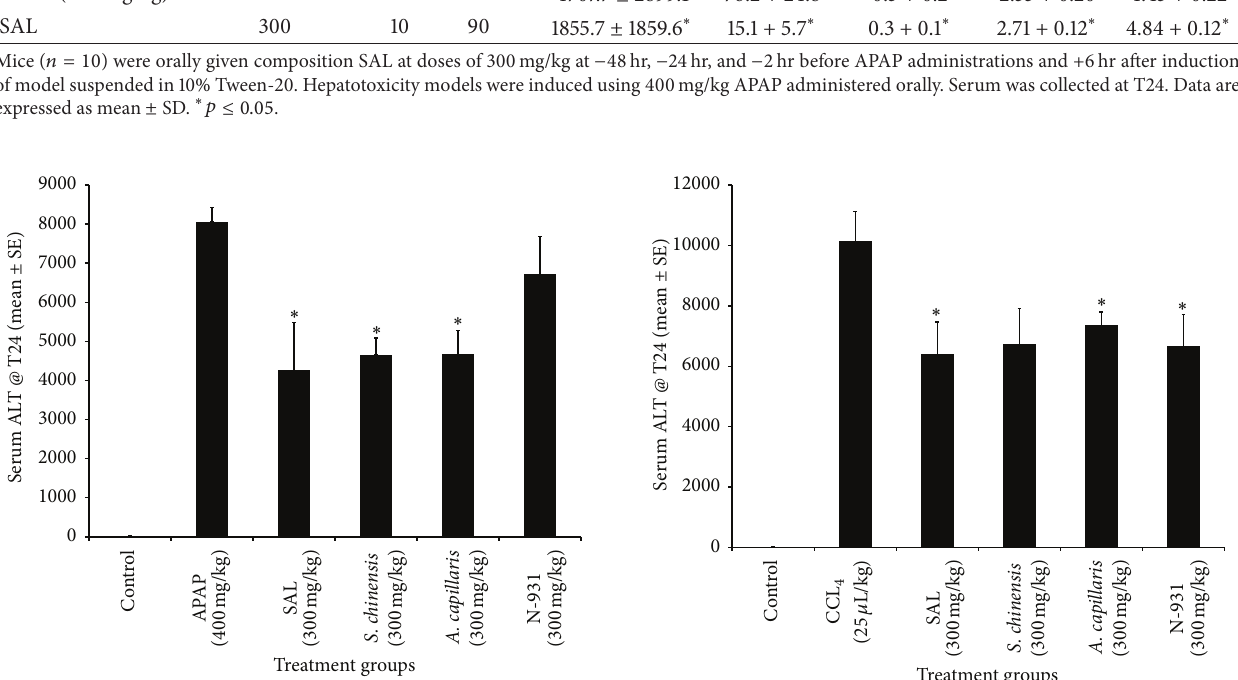
Figure2:LiverprotectionactivityofthecompositionofSALagainst its individual components at a dose of 300 mg/kg in CCl 4 induced hepatotoxicity model. ∗ 𝑝 ≤ 0.05